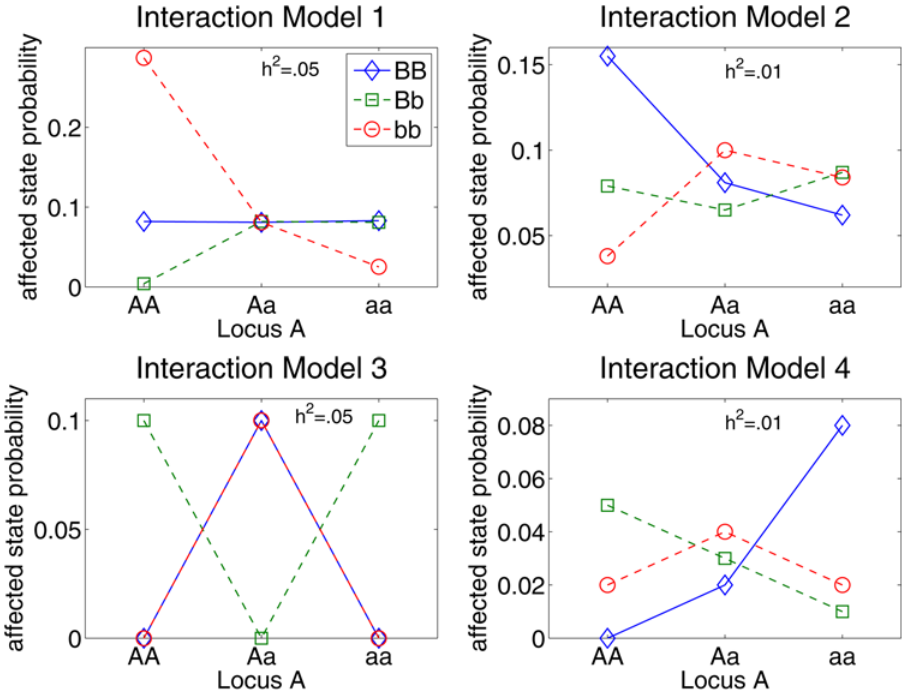
Figure 1. Penetrance diagram for genetic models used to compare strategies for filtering SNPs from case-control data. All four genetic models involve two interacting loci. Each point in a diagram is the probability of an individual being in the affected phenotype state for the given genotype combination. Model 3 is the purely epistatic XOR model, which displays no independent effects. The other interaction models display a small main effect through locus B. The models in the left column have .05 heritability and the models in the right column have .01 heritability. Analysis results for these simulated models are given in Figure 2.